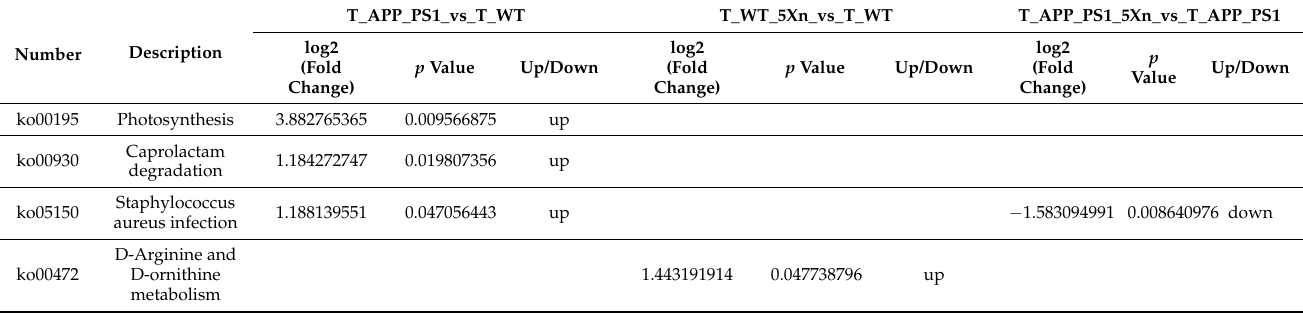
Table 2. Differential KEGG pathways predicted via PICRUSt software in the Xn therapy